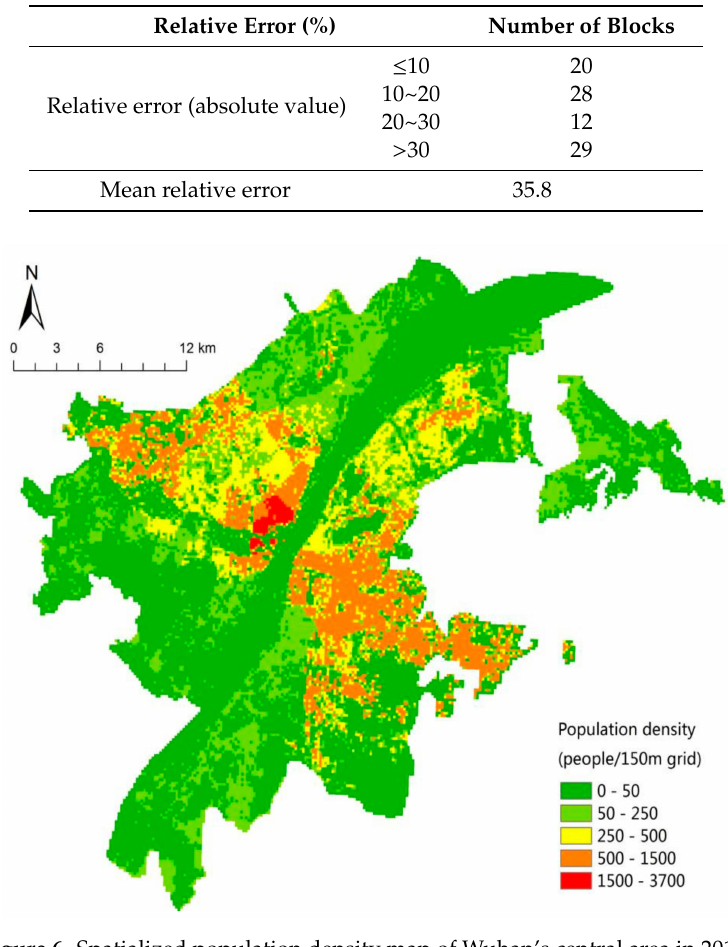
Table 3. The result of error evaluation on street scale.